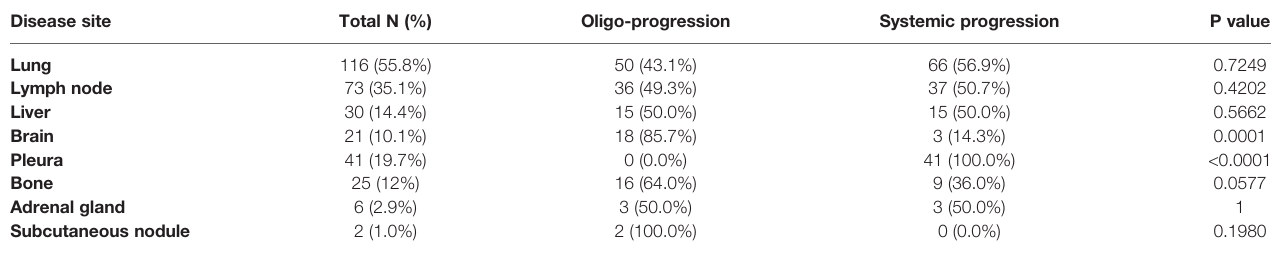
TABLE 2 | Progression sites beyond immunotherapy resistance. Disease site